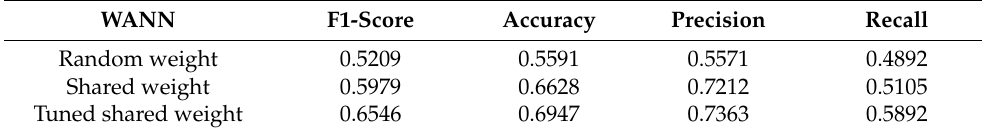
Table 5. Performance of WANN on the test set using different weight schemes. WANN F1-Score Precision Recall Random